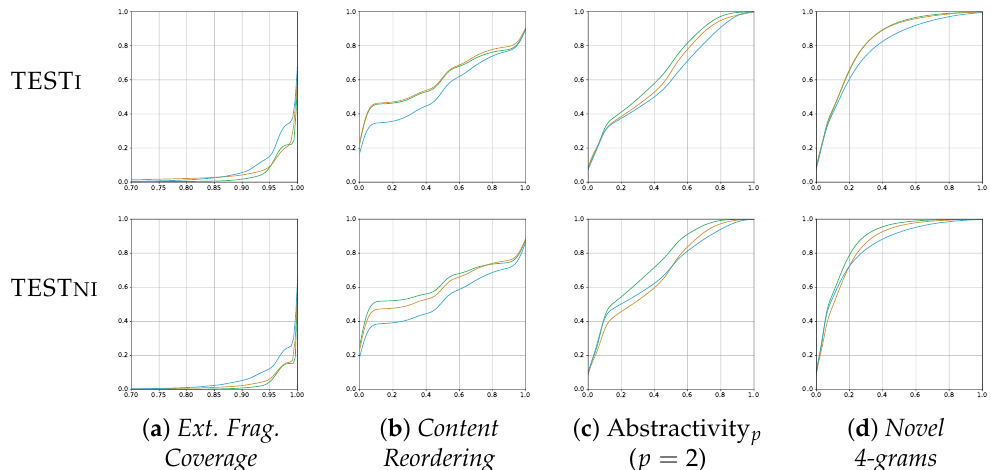
Figure 2. Cumulative distribution of 4 abstractivity indicators for models NAS ES , mBART, mT5 for